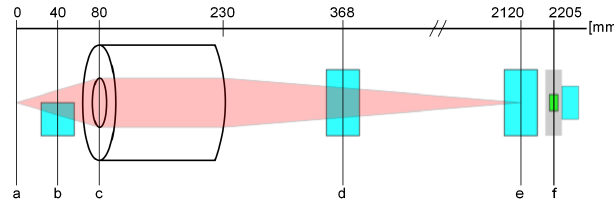
FIG. 1. Experimental setup. After the protons are produced in the laser-matter interaction at the target (a), the divergent bunch enters the solenoid (c). For characterization of the initial beam, a RCF stack can optionally be placed in front of the solenoid at 40 mm (b). For detection of the bunch at larger distances, either a RCF stack can be used for dose analysis and transverse beam profile measurements at distances up to 2120 mm (d),(e) or alternatively a diamond detector at 2205 mm for time-of-flight measurements with also a RCF stack attached to detect the protons after passing the 20 (cid:1) m thin diamond